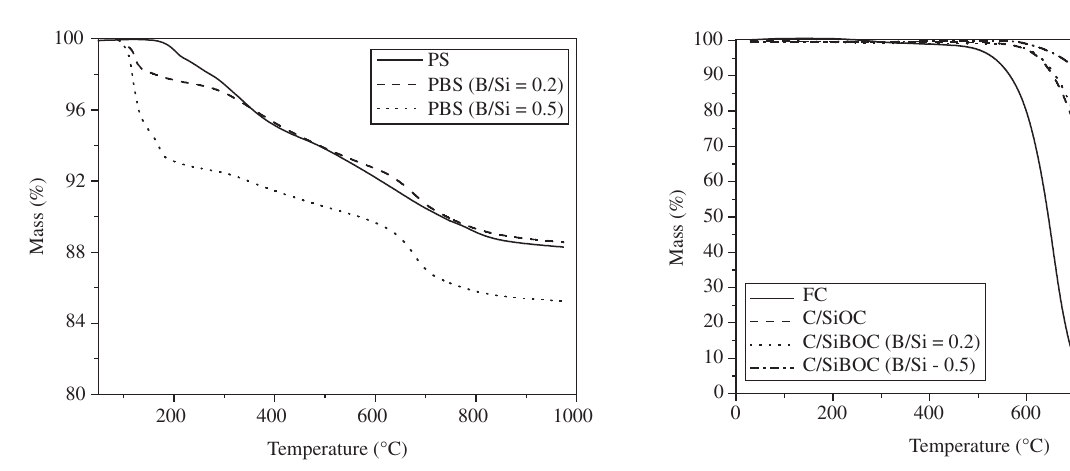
Figure 2. TGA curves for PS and PBS gels derived from MTES (air, 10 °C/min).